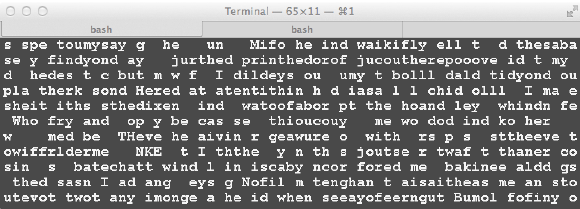
Figure 4. CS1: First “graphics” encounter, character-plot sine wave